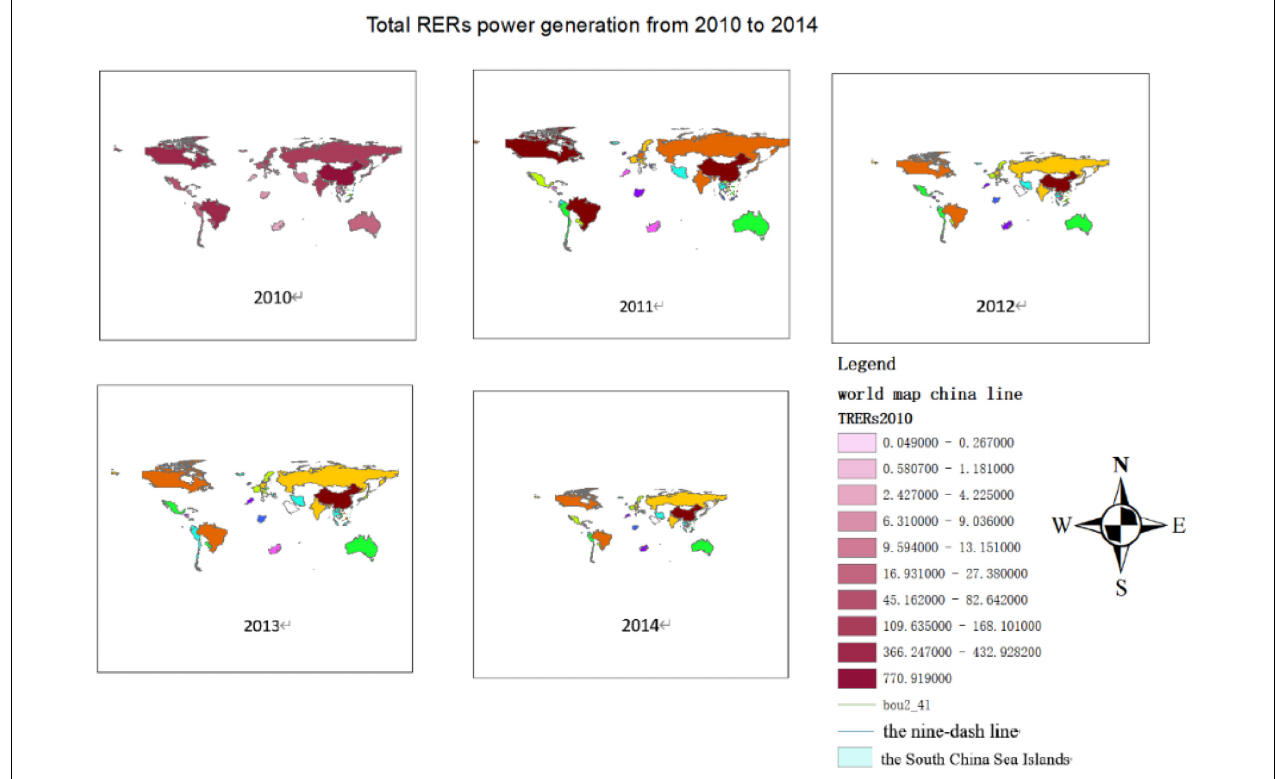
FIGURE 1 | Total RERs power generation from 2010 to